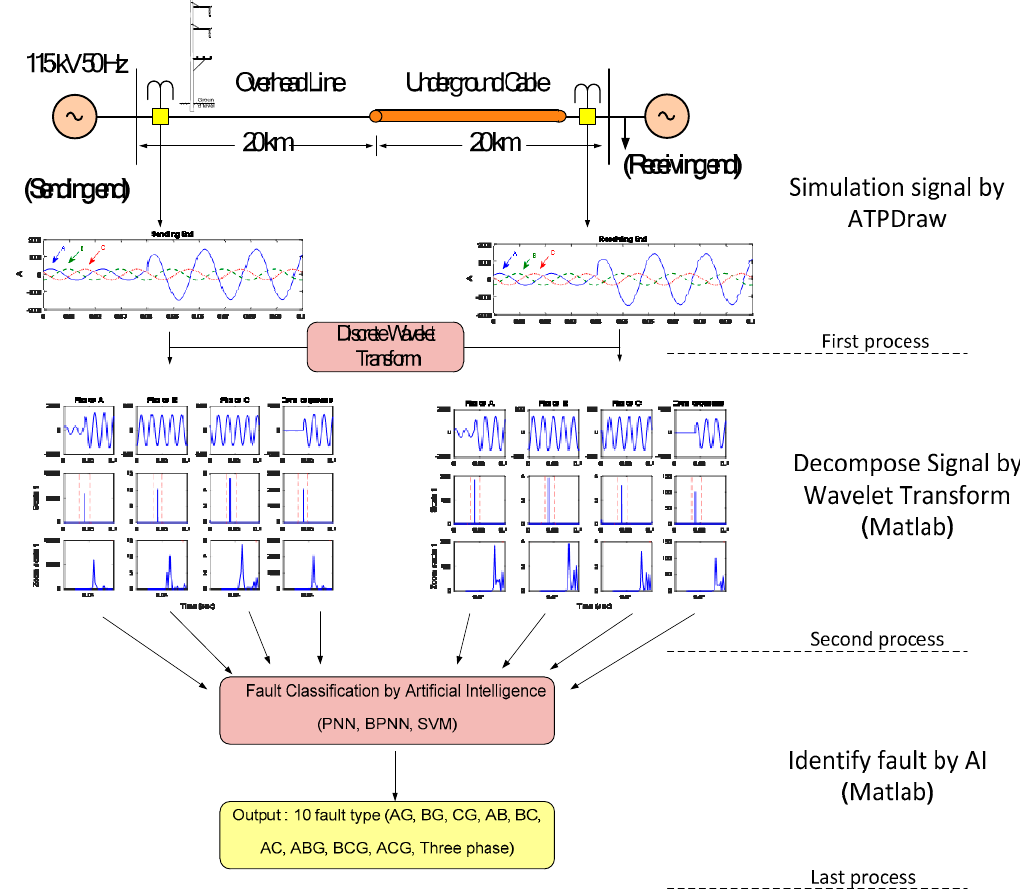
Figure 1. Overall process for simulation and analysis of faults in a 115-kV hybrid transmission line.